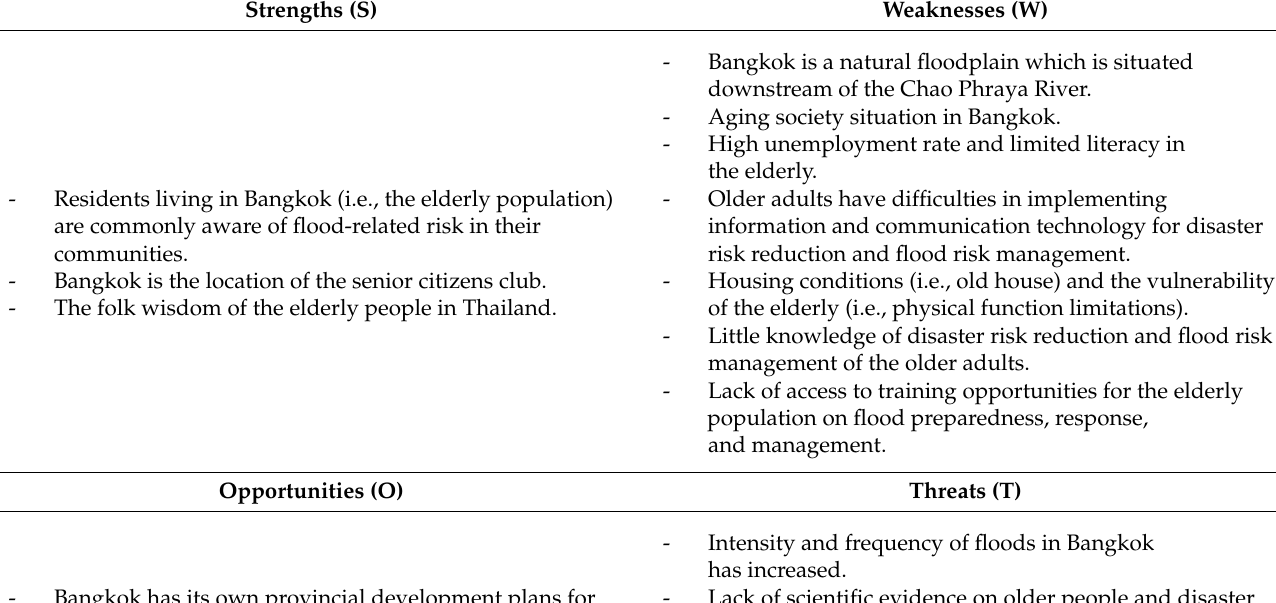
Table 3. Strengths, weaknesses, opportunities, and threats analysis of flood literacy, perception, and related actions of the elderly